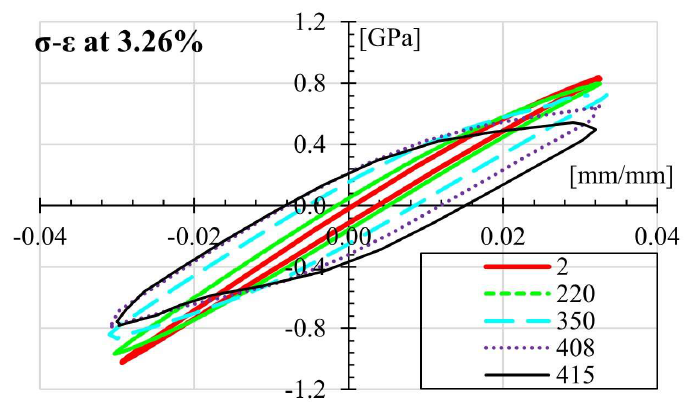
Figure 7. Exemplary result for the hysteresis loops at ±3.26% ε.